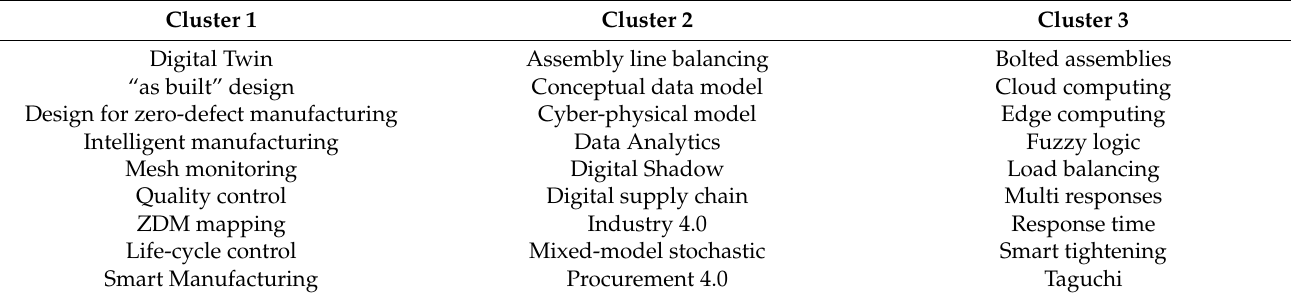
Table 1. Clusters as Constructed by VOSviewer Software.